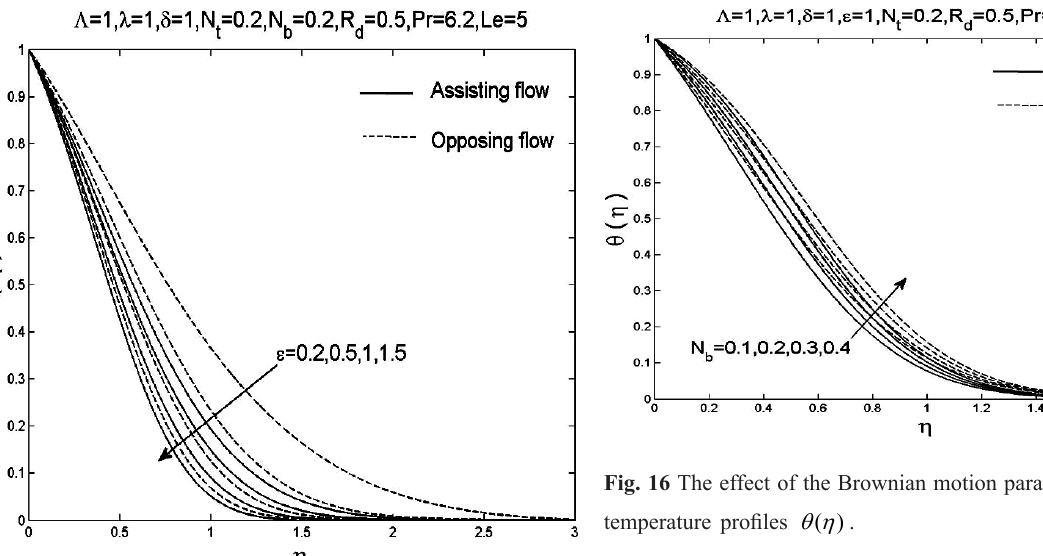
Fig. 14. The effect of the velocity ratio parameter ε on the tem- perature profiles ( ) θη .